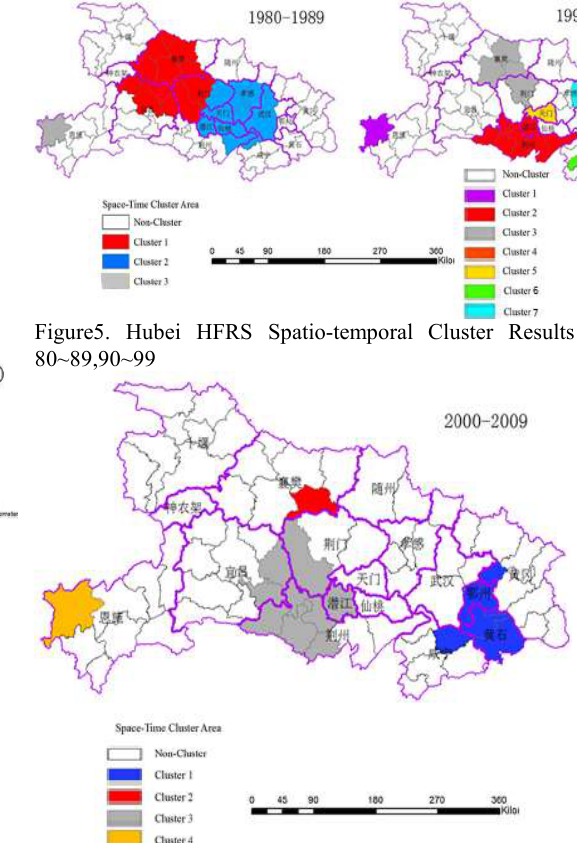
Figure6. Hubei HFRS Spatio-temporal Cluster Results for